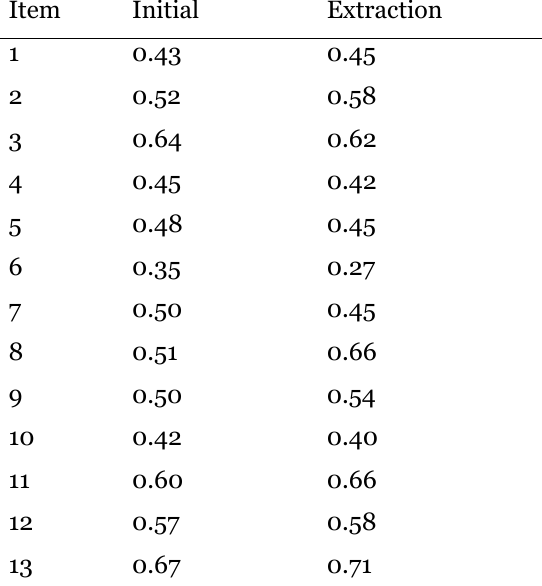
Communalities for the EFMC-MOOC Sample